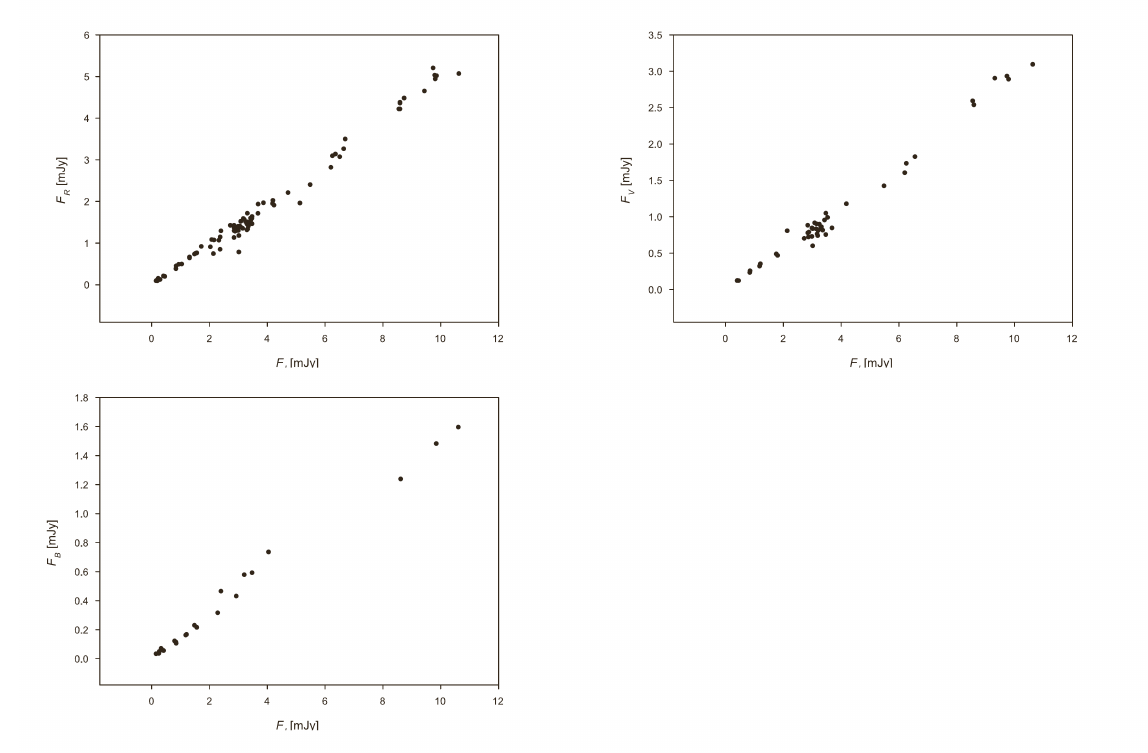
Figure 4. Flux–flux diagrams for outburst 2006–2007.